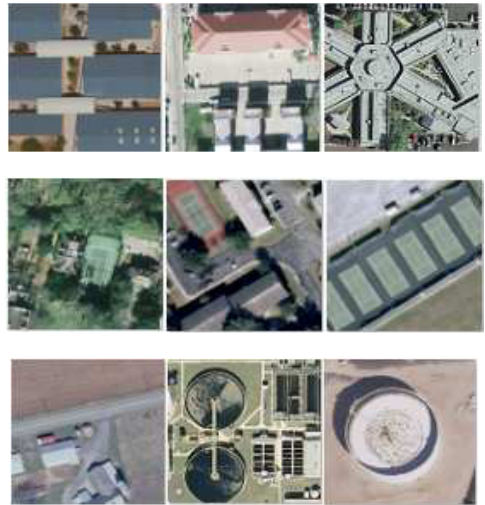
Figure 2. Some samples belonging to buildings, tennis court and storage tanks